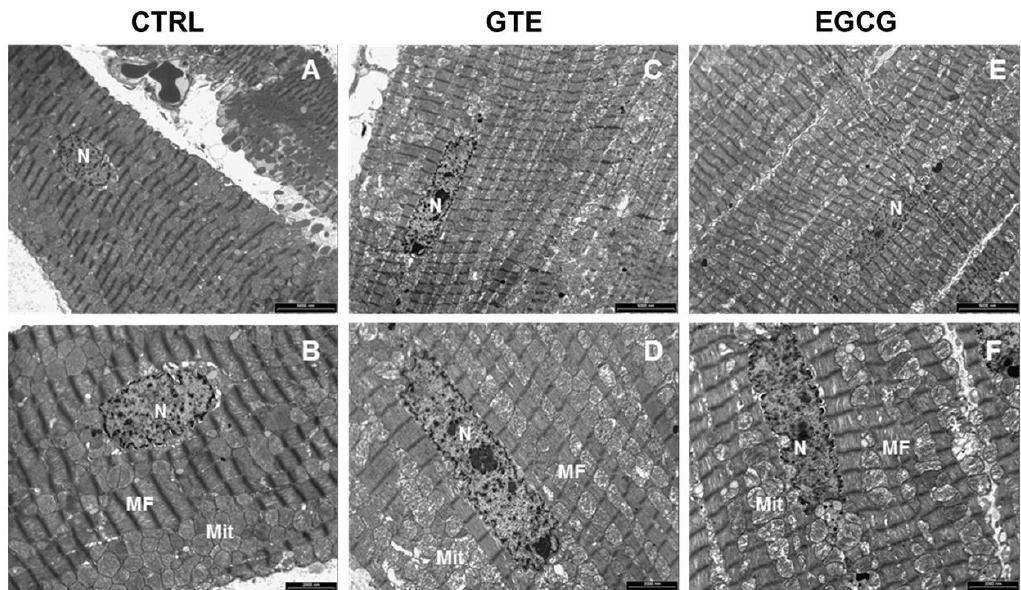
Figure 5. Transmission Electron Microscopy (TEM) analysis of the LV heart tissue. Representative Figure 5. TEM analysis of the LV heart tissue. Representative images of the LV myocardium from images of the LV myocardium from CTRL ( A , B ) n = 1, GTE ( C , D ) n = 1, and EGCG ( E , F ) n = 1 rat CTRL ( A , B ) n = 1, GTE ( C , D ) n = 1, and EGCG ( E , F ) n = 1 rat hearts, illustrating at different hearts, illustrating at di ff erent magnification the distribution of mitochondria (Mit) and myofibrils (MF) magnification the distribution of mitochondria (Mit) and myofibrils (MF) in cardiomyocytes. n : in cardiomyocytes. n : nucleus. Scale bars = 5 µ m ( A , C , E ); scale bars = 2 µ m ( B , D , F nucleus. Scale bars = 5 µm ( A , C , E ); scale bars = 2 µm ( B , D , F ).